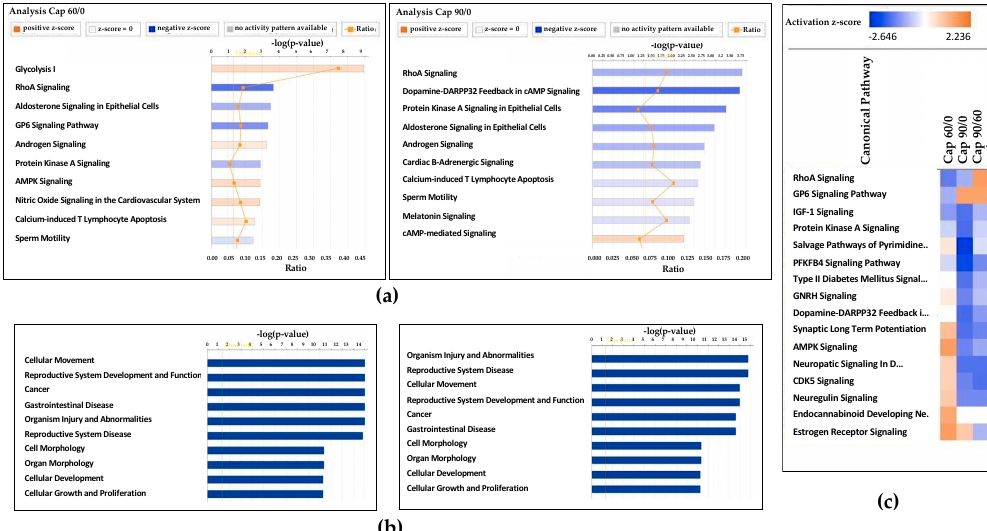
Figure 3. Differential phosphoproteomic analysis using ingenuity pathway analysis (IPA) for the Cap 60/0 and Cap 90/0 datasets. ( a ) Representative bar chart of the IPA-revealed canonical pathways for the Cap 60/0 and Cap 90/0 datasets. The orange lines represent the ratios of changed genes to the total number of genes in specific pathways. The threshold (set to 1.3) is scored as the − log p -value from Fisher’s exact test and indicates the minimum significance level. The ratio indicates the number of molecules in the dataset that mapped to the pathway listed divided by the total number of molecules that mapped to the canonical pathway within the IPA database. ( b ) Representative bar charts determined by IPA showing the biological functions associated with the phosphoproteins for the Cap 60/0 and Cap 90/0 datasets. ( c ) Heatmaps generated through IPA canonical pathway analysis for comparison among all datasets (Cap 60/0, Cap 90/0, and Cap 90/60). Upregulated pathways are shaded orange, and downregulated pathways are shaded blue. The intensity indicates the degree to which each gene was upregulated or downregulated as determined by the IPA-determined z-score.